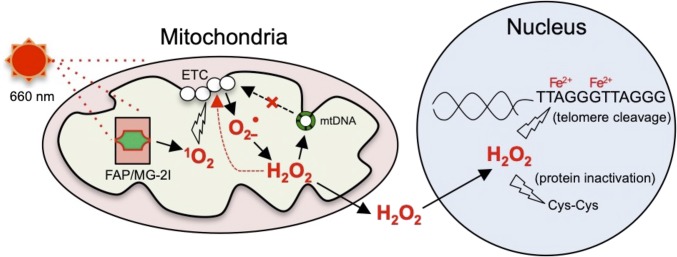
Working model of how mitochondrially generated hydrogen peroxide causes telomere damage. On 660-nm light exposure, the complex of Mito-FAP and MG-2I produces singlet oxygen. Singlet oxygen can induce oxidative damage to mitochondrial ETC, initiating a persistent secondary wave of superoxide and hydrogen peroxide generation. Hydrogen peroxide generated by mitochondria is able to damage mtDNA, which amplifies the damage to ETC. Hydrogen peroxide can further diffuse to the nucleus and is sufficient to cause nuclear protein oxidation and preferential telomere DNA damage but not overall nuclear DNA damage.